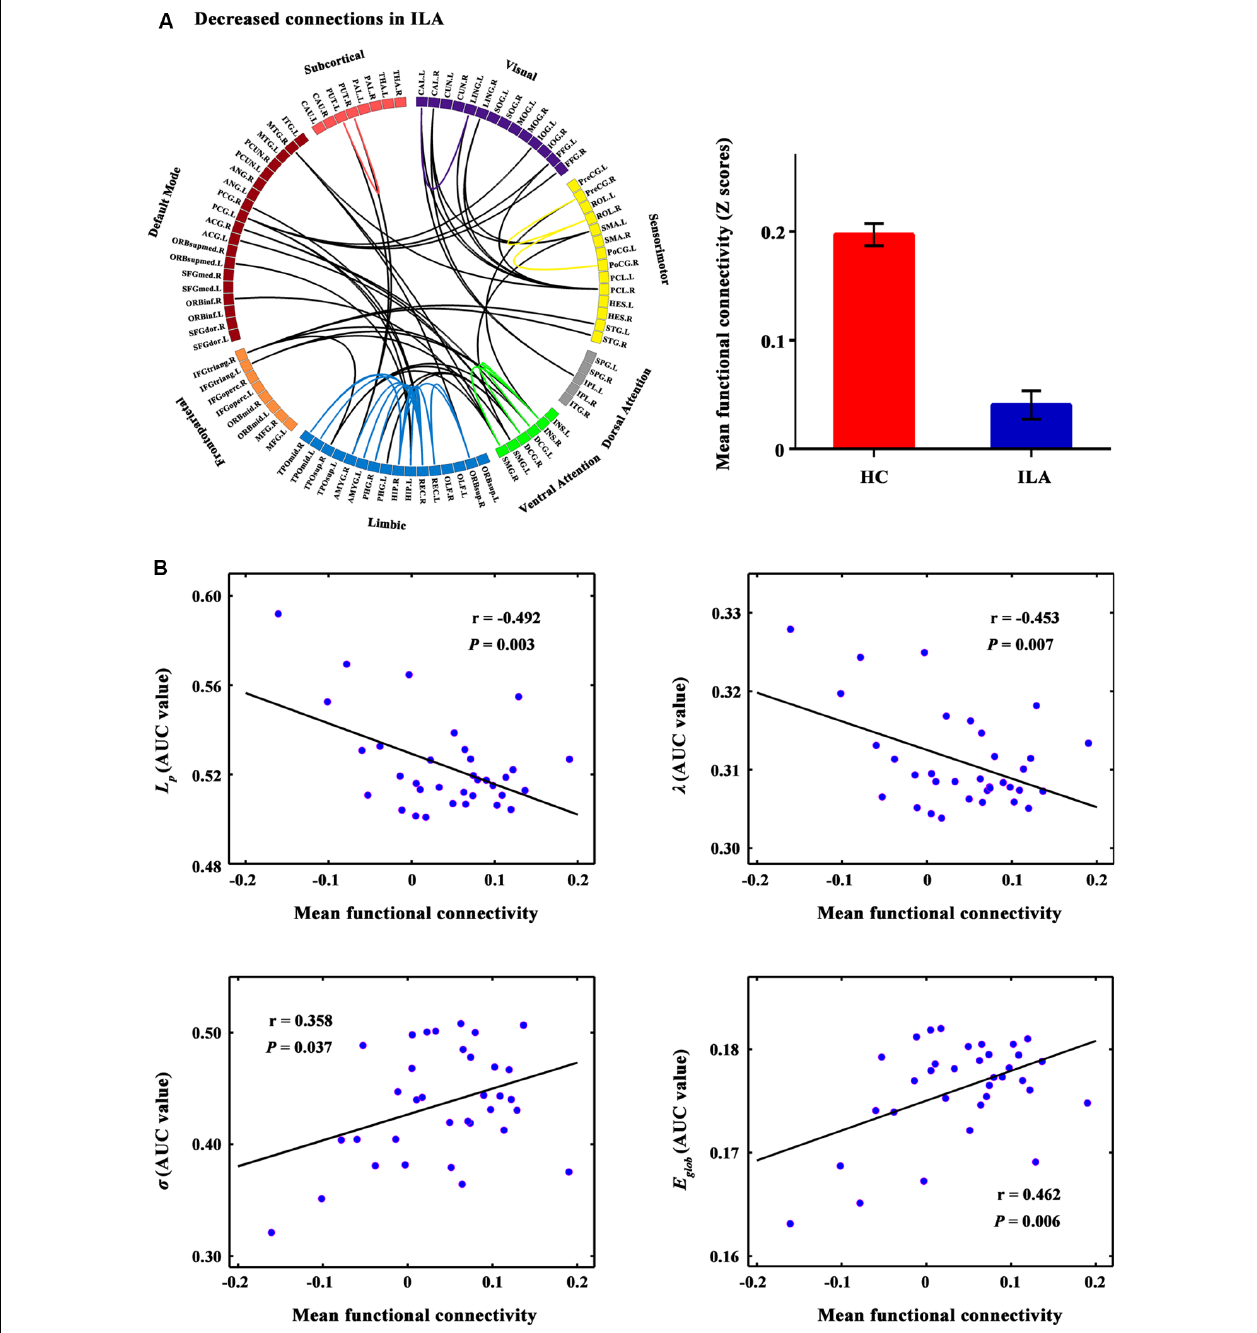
FIGURE 2 | The connected network showing decreased functional connections in ILA patients and their relationships with global network metrics. (A) Network-based statistic (NBS) analysis identified a large disconnected network in ILA patients. This network comprises functional connections linking different functional modules (e.g., default mode, frontoparietal, ventral attention, and limbic systems) and connections within single modules (e.g., limbic and ventral attention systems). (B) Scatter plots of the mean functional connectivity of this connected network against global network metrics. The mean connectivity value showed significant correlations with four global network metrics ( L p : r = − 0.492, P = 0.003; λ : r = − 0.453, P = 0.007; σ : r = 0.358, P = 0.037; E glob : r = 0.462, P = 0.006) in the ILA group. ILA, ischemic leukoaraiosis.